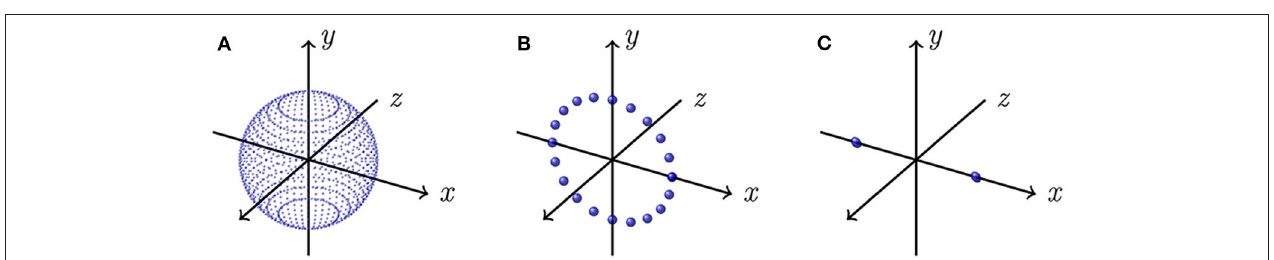
3); (B) All points are uniformly distributed on a circle lying in the = 1). =